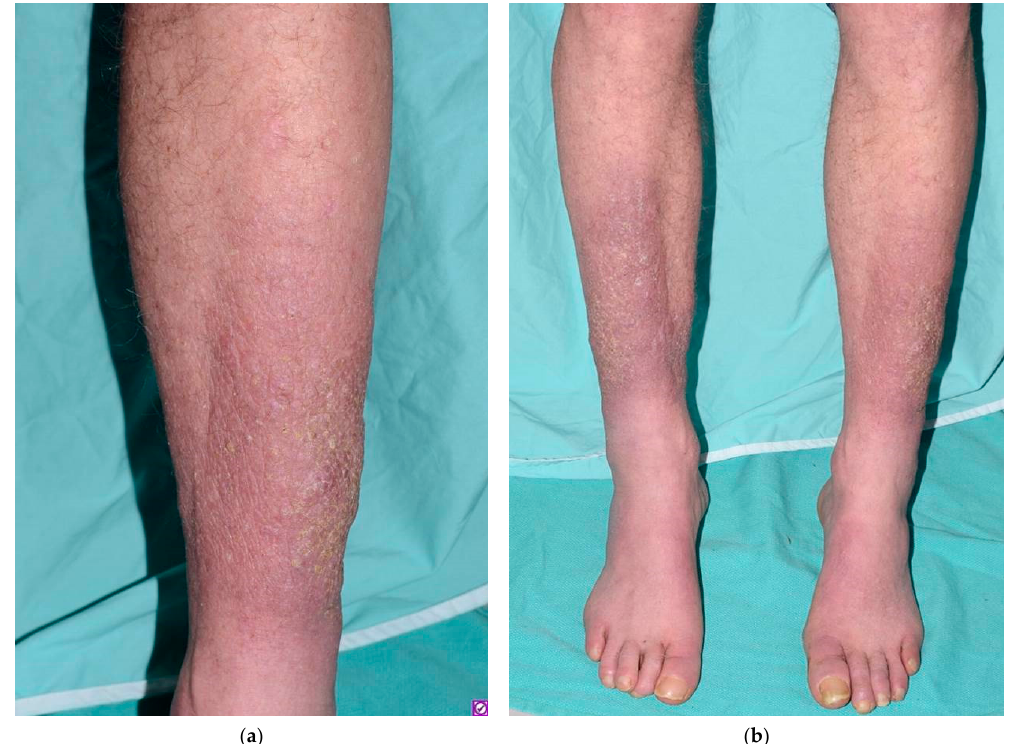
Figure 1. Indurated, pink, peau d’orange-appearing plaques and overlying adherent xerotic scale. ( a ) Closer view of the left shin; ( b ) both lower shins. Dermatopathology 2021 , 8 ,